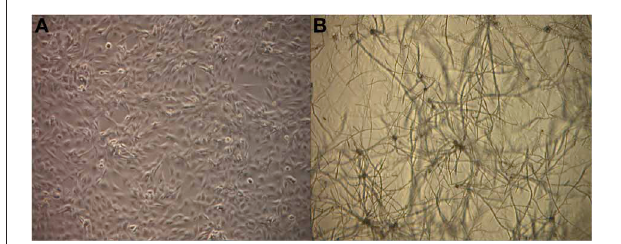
FIGURE 1 | Germinating Alternaria alternata spores in the presence of human airway epithelial cells. BEAS-2B cells were incubated with live A. alternata spores for 24h under normal conditions at 37 ◦ C, 5% CO 2 . Cultures were imaged using an inverted phase-contrast microscope. Magnification: 40 × . (A) Untreated BEAS-2B cells, (B) BEAS-2B cells treated with A. alternata spores at